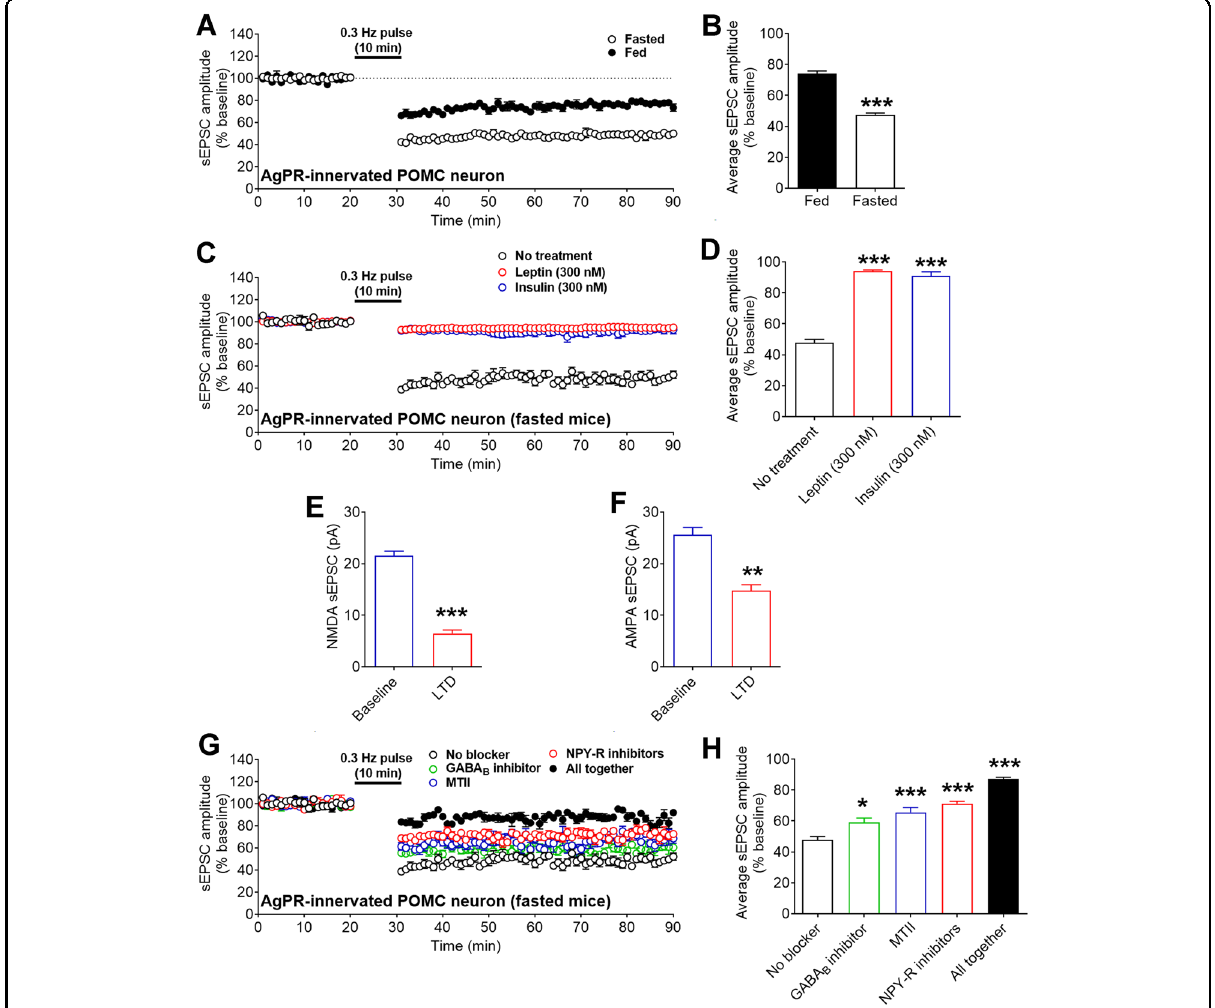
SEM. n = 6 per group. *** P < 0.001 in two-tailed unpaired t tests. C Temporal changes in sEPSC amplitudes in AgRP-innervated POMC neurons (from fasted mice) after the brain slices were pre-incubated with vehicle, leptin, or insulin. D The average sEPSC amplitude after AgRP stimulation in ( C ). Data are mean ± SEM. n = 5 or 6 per group. *** P < 0.001 vs. the no treatment group in one-way ANOVA analyses followed by post hoc Tukey ’ s